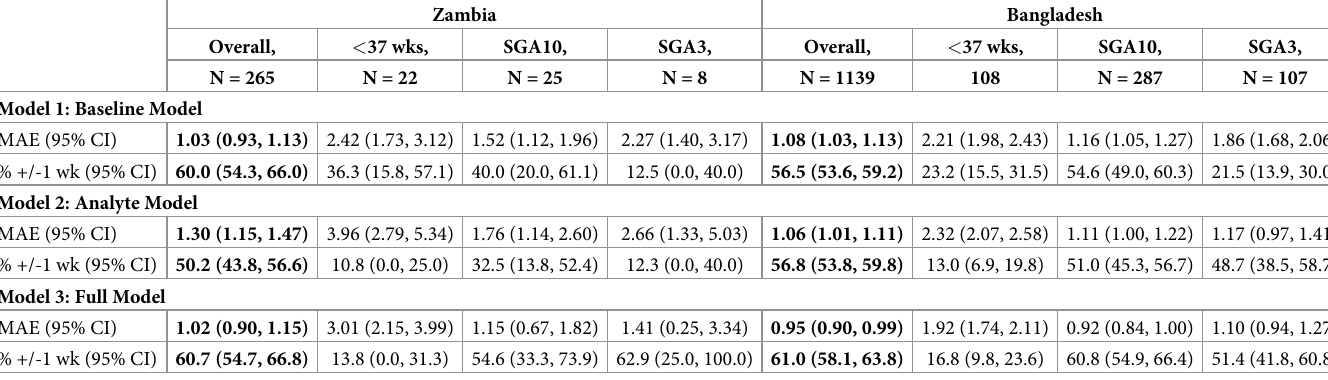
ples from Bangladesh, Model 3 significantly outperformed Models 1 and 2 in accurately estimat- ing GA (MAE (95% CI) 0.95 (0.90, 0.99) vs. 1.08 (1.03, 1.13) and 1.06 (1.01, 1.11), respectively). When applied to cord blood samples from preterm infants in Zambia (n = 22), all models generally performed poorly. The best performing model in this group was Model 1, with an MAE (95% CI) of 2.42 (1.73, 3.12) and estimated GA within 1 week in 36.3% of infants. Models performed slightly better in estimating preterm GA in cord blood samples from Bangladesh Table 5. Cord blood samples: MAE and proportion estimated within 1 week of ultrasound-assigned gestational age. Zambia Bangladesh Overall, < 37 wks, SGA10, SGA3, Overall, < 37 wks, SGA10, SGA3, N = 265 N = 22 N = 25 N = 8 N = 1139 108 N = 287 N =